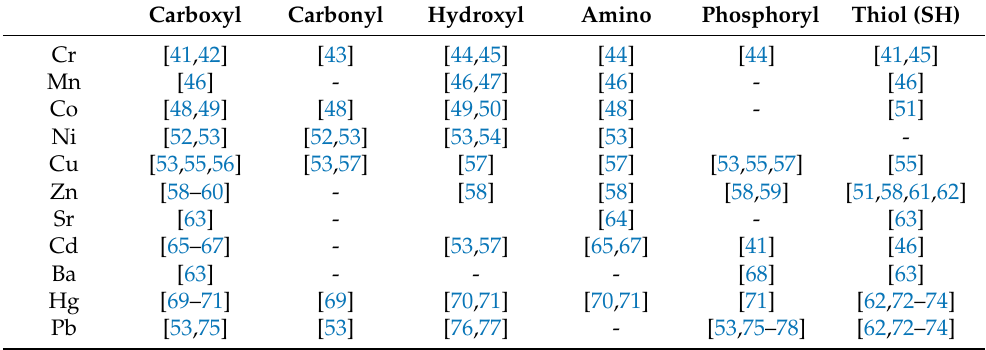
Table A1. The role of organic groups in metal immobilization according to literature